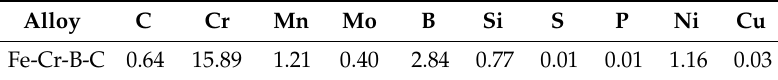
Table 1. Chemical composition of the Fe-Cr-B-C alloy